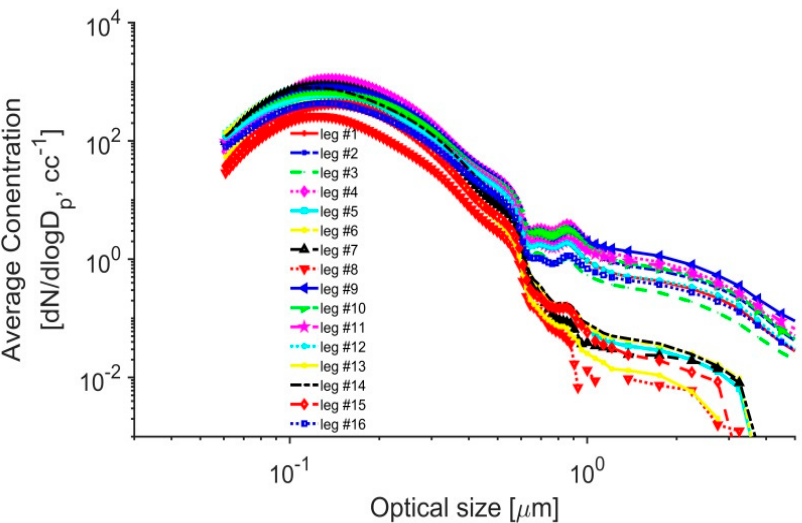
Figure 1. Example of combined size distributions generated for each FL during a given day (25 February 2013). Here and in the following plots, aerosol characteristics represent FL-averaged values. Elevation and time of each FL are shown in Figure 2.